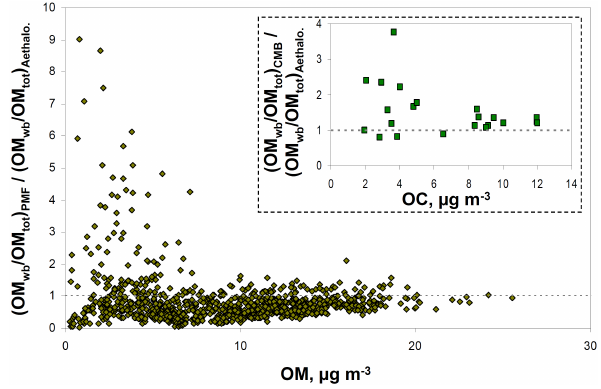
Fig. 12. Ratios of OM wb contributions obtained using the Aethalometer model and PMF (and using the Aethalometer and CMB models) as a function of OM (OC) mass